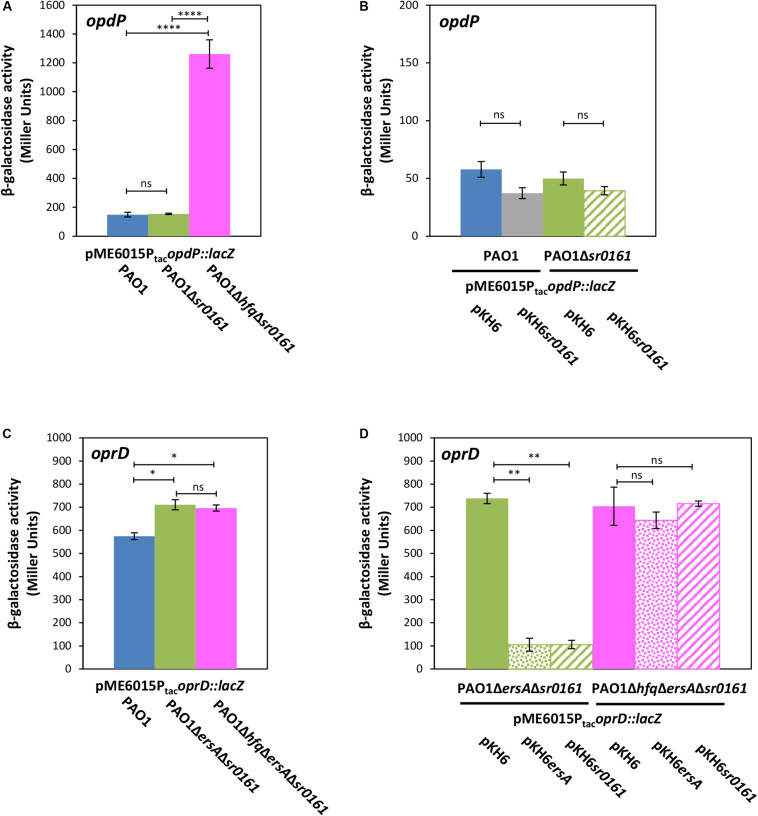
The sRNAs Sr0161 does not regulate opdP translation. (A) The strains PAO1 (blue bar), PAO1Δsr0161 (green bar), and PAO1ΔhfqΔsr0161 (pink bar) harboring plasmid pME6015PtacopdP::lacZ were grown in LB medium. Samples were withdrawn at an OD600 of 2.0. The bars represent the β-galactosidase values conferred by the opdP::lacZ translational fusion gene encoded by plasmid pME6015PtacopdP::lacZ.
(B) The strains PAO1 (pKH6) (blue bar), PAO1(pKH6sr0161) (gray bar), PAO1Δsr0161(pKH6) (green bar), and PAO1Δsr0161(pKH6sr0161) (striped green bar) harboring plasmid pME6015PtacopdP::lacZ were grown in LB medium supplemented with 0.2% arabinose to induce sRNA gene expression from plasmid pKH6sr0161. Samples were withdrawn at an OD600 of 2.0. The bars represent the β-galactosidase values conferred by the opdP::lacZ translational gene fusion encoded by plasmid pME6015PtacopdP::lacZ. (C) The strains PAO1 (blue bar), PAO1ΔersAΔsr0161 (green bar) and PAO1ΔhfqΔersAΔsr0161 (pink bar) harboring plasmid pME6015PtacoprD::lacZ were grown in LB medium. Samples were withdrawn at an OD600 of 2.0. The bars represent the β-galactosidase values conferred by the oprD::lacZ translational fusion gene encoded by plasmid pME6015PtacoprD::lacZ. (D) Ectopic expression of ersA and sr0161 in strains PAO1ΔersAΔsr0161 (green bars) and PAO1ΔhfqΔersAΔsr0161 (pink bars) harboring plasmid pME6015PtacoprD::lacZ. The β-galactosidase values conferred by the oprD::lacZ translational fusion gene in either strain in the absence of ersA/sr0161 expression (solid bars) and in the presence of ersA (dotted bars) or sr0161 (striped bars) are indicated by bars. Statistical analyses were performed with AGOVA test with post hoc multiple comparison as described in section “Materials and Methods.” ns (non-significant); *P < 0.05, **P < 0.01, ***P < 0.001, ****P < 0.0001.